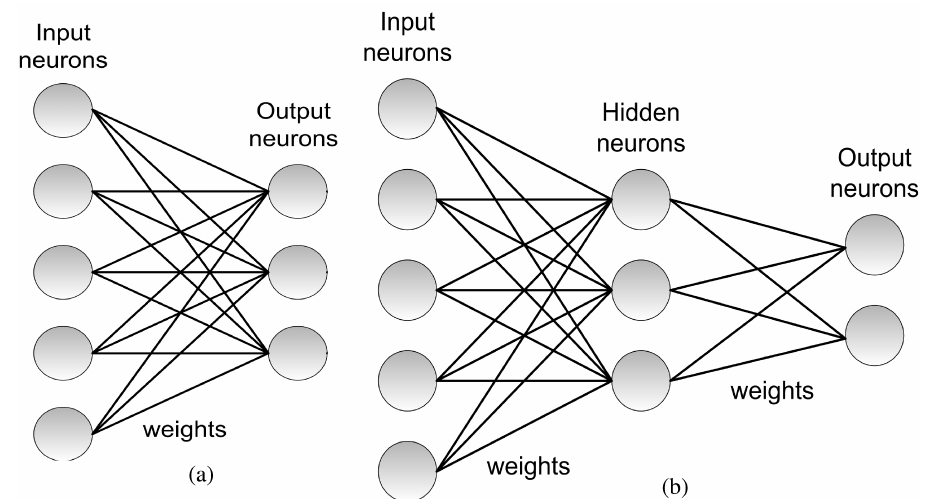
Figure 2. ( a ) Architecture of a single layer perceptron. The architecture consists of a layer on input neurons fully connected to a single layer of output neurons. ( b ) Extension to a multi-layer perceptron including more than one layer of trainable weights. In this example, the network includes 3 layers: input, hidden and output layer. Each connection between two neurons is given by a certain